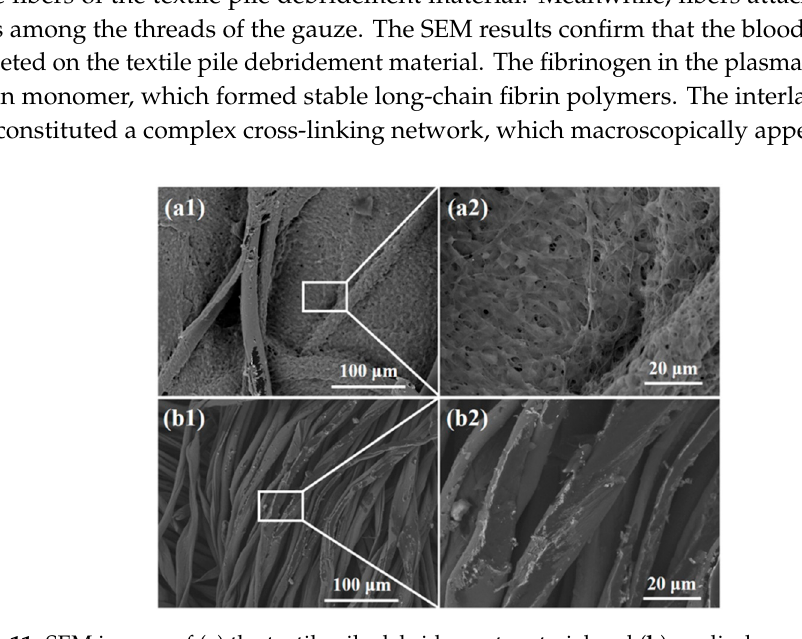
Figure 11. SEM images of ( a ) the textile pile debridement material and ( b ) medical gauze at 30 min in the blood coagulation